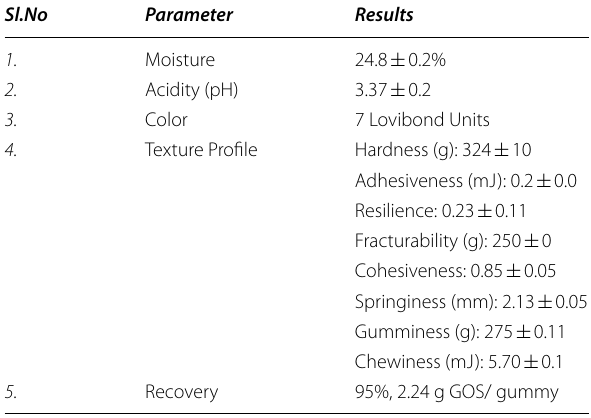
Table 7 Physico chemical characteristics of the 100% GOS